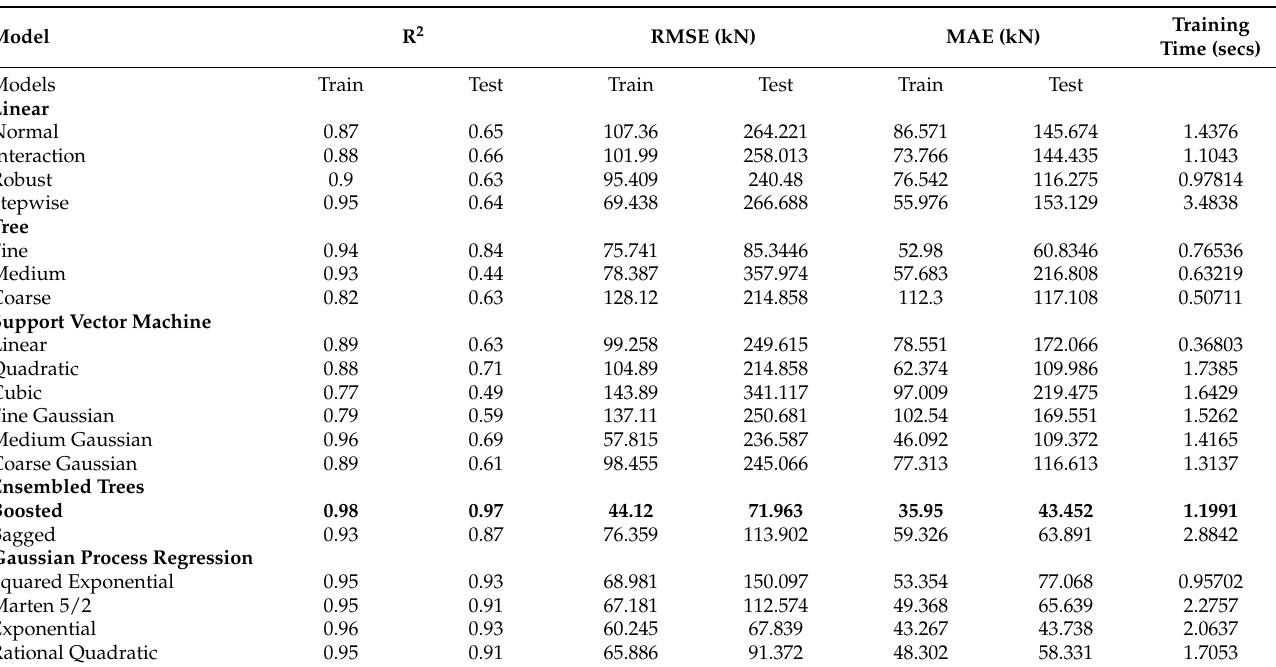
Table 3. Experimental database for FRP-reinforced concrete slab-column